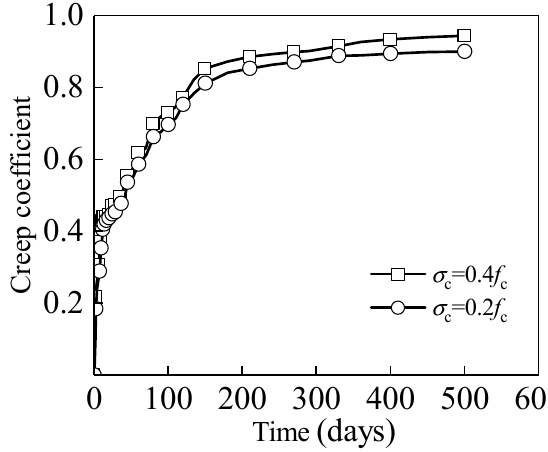
Figure 2. Variation curve of concrete creep coefficient.